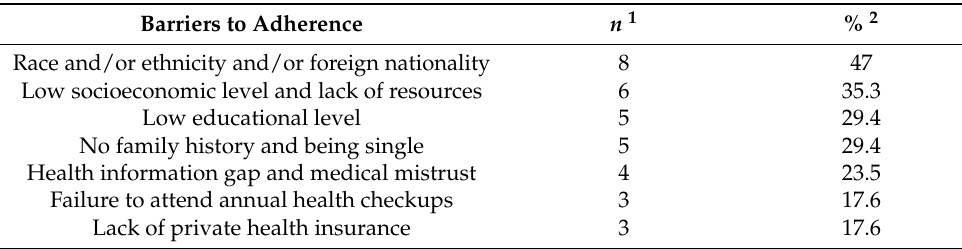
Table 2. Barriers to breast cancer–screening adherence.